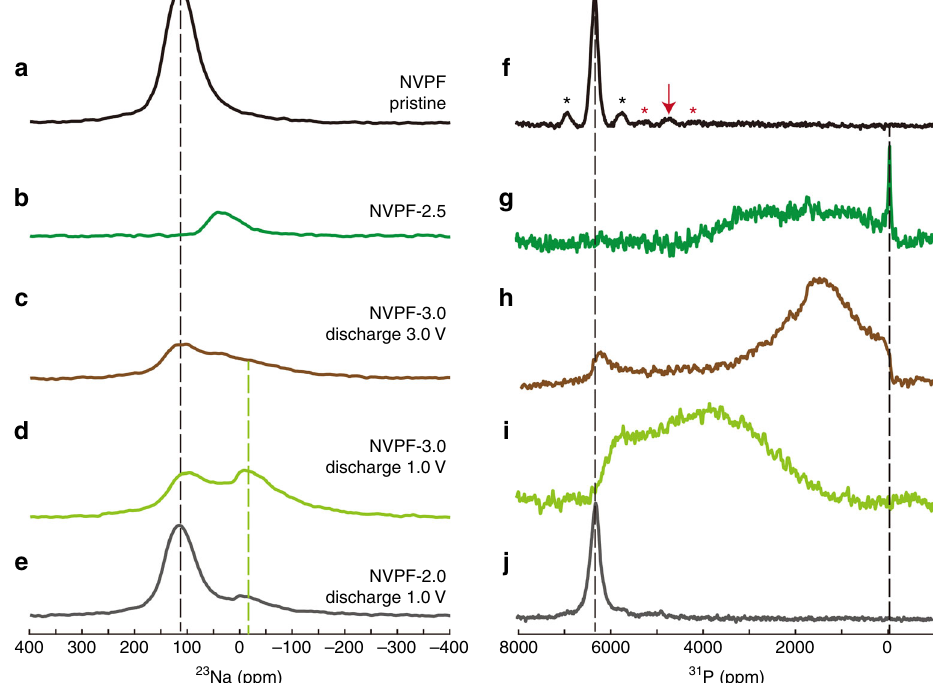
Fig. 6 NMR spectroscopic evidence of sodium disorder in NVPF. a – e 23 Na and f – j 31 P magic angle spinning-nuclear magnetic resonance spectra after a Hahn echo sequence recorded at 4.7 T and a spinning rate of 50 kHz. a , f Pristine NVPF. b , g NVPF-2.5. c , h NVPF-3.0 discharged to 3.0 V. d , i NVPF-3.0 discharged to 3.0 V and 1.0 V respectively. e , j NVPF-2.0 discharged to 1.0 V. The stars indicate spinning sidebands, the red arrow shows a small contribution from neighboring V 4 + ions in the pristine NVPF. The dashed lines are guide for the eyes. The 23 Na spectra are shown without modi fi cation, while the 31 P spectra levels were adjusted for clarity